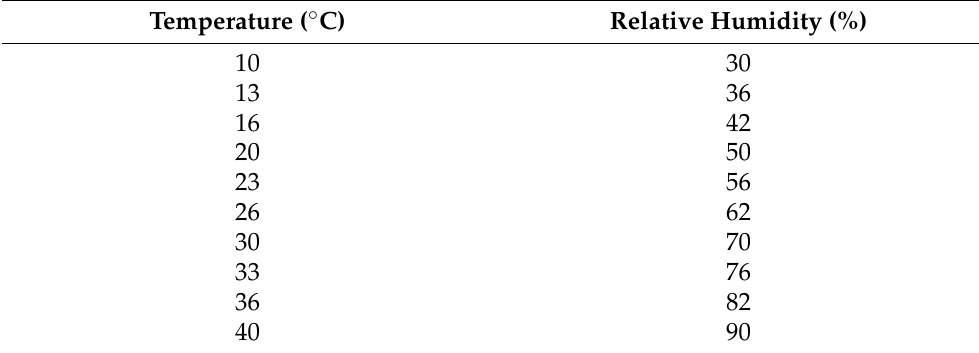
Table 2. Temperature and relative humidity setpoints used to create the calibration dataset. Ten temperature setpoints and ten relative humidity setpoints resulted in 100 setpoint pairs.